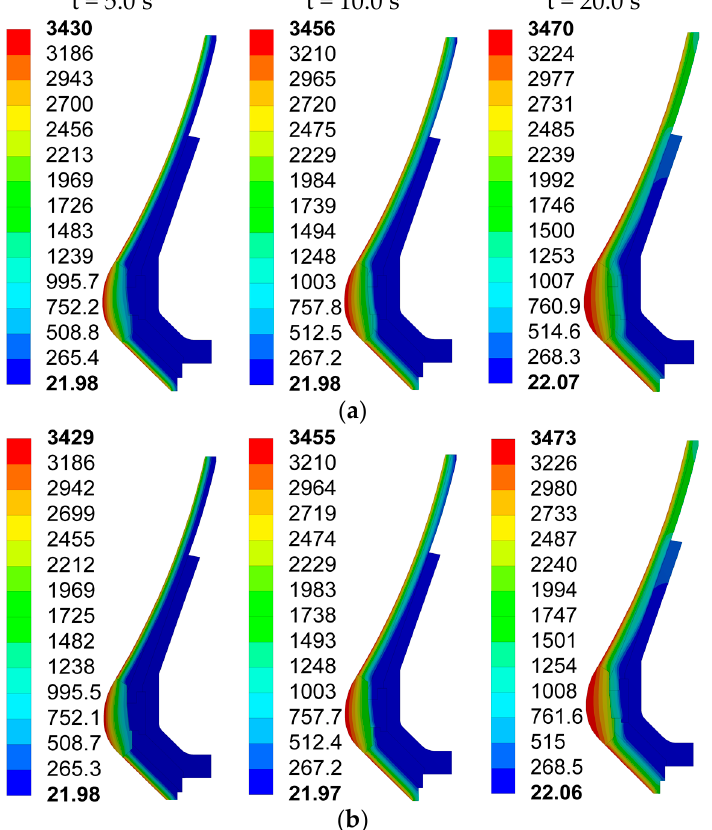
Figure 8. Temperature distribution graphs for the two types of interface treating methods. ( a ) The interfaces are treated as bonded ones; ( b ) the interfaces are treated as contact ones, where thermal contact resistance, radiation between the contact and the target, and energy dissipation caused by friction are effective.